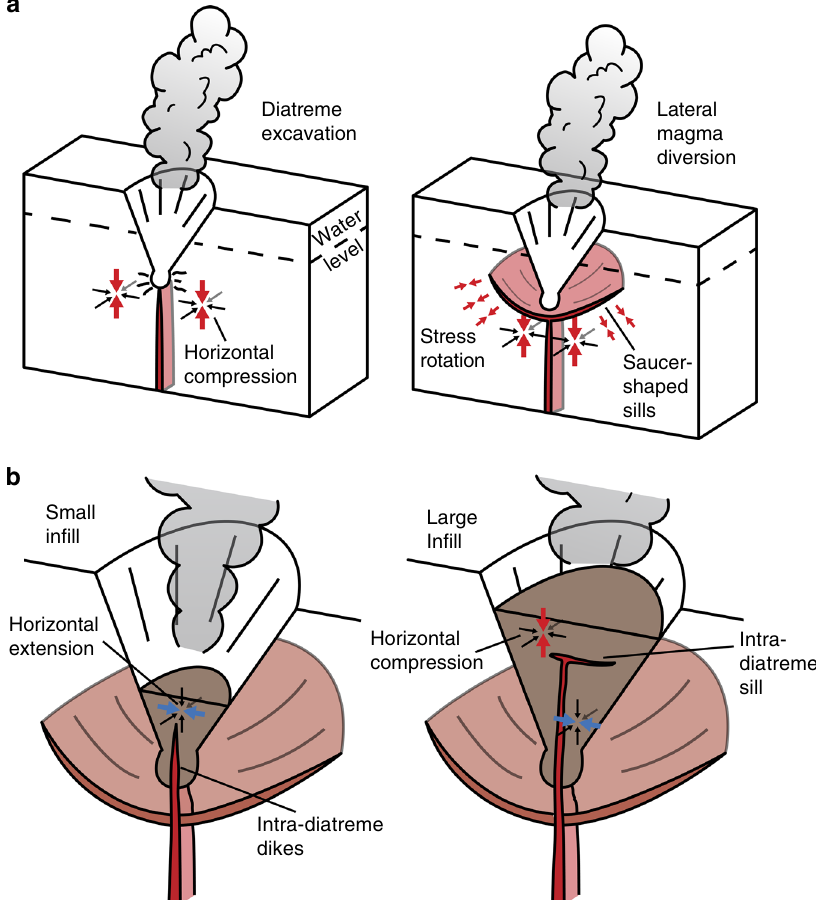
Fig. 4 Sketch of a maar-diatreme eruption and formation of the magmatic plumbing system. a The proto-diatreme (aka excavation stage) and b developing diatreme (aka in fi lling stage). The colored arrows represent the orientation of the minimum compressional stress ( σ 3 ), the blue and red colors represent the differential tectonic stress, extensional and compressional,